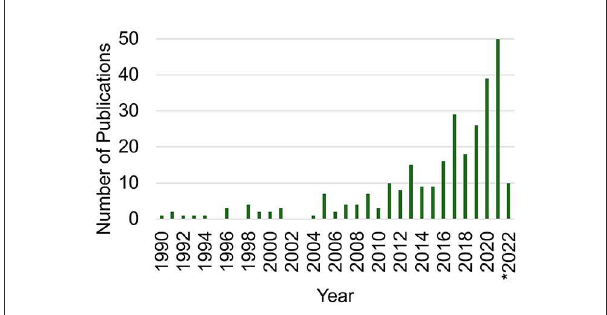
FIGURE6 The number of publications on closed-loop agricultural systems increased steadily from 1990 to 2022. *The article pull occurred on February 2, 2022.